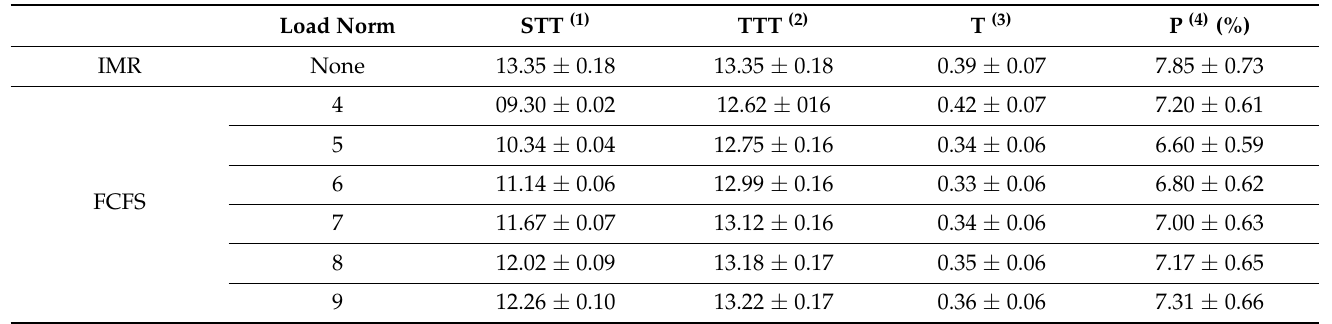
Table 4. Simulation results for jobs CV =